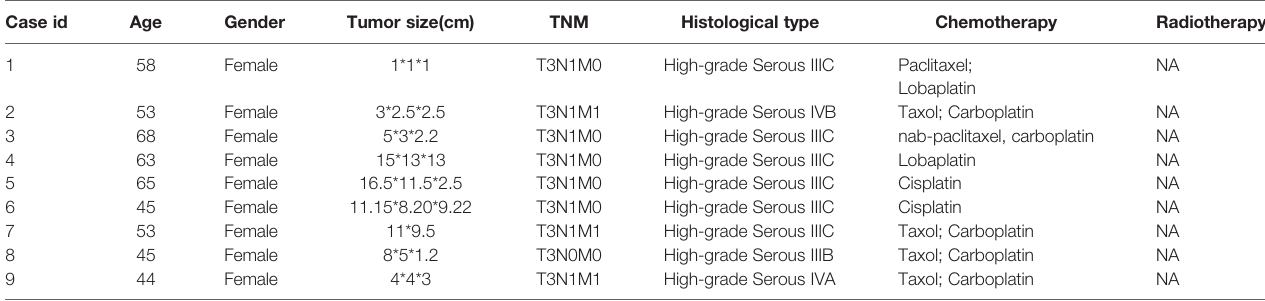
TABLE 3 | Clinicopathological parameters of